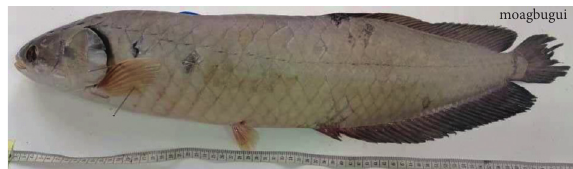
Figure 2: The body of Heterotis niloticus .